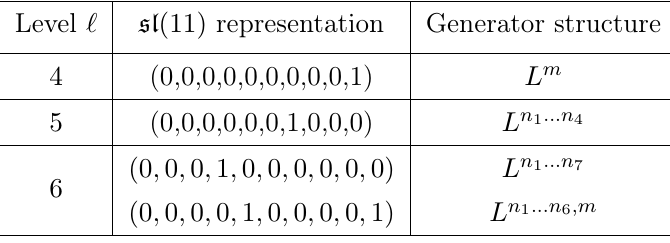
Table 6 . Level decomposition of the R ((cid:3) 10 ) representation of E 11 under gl (11)